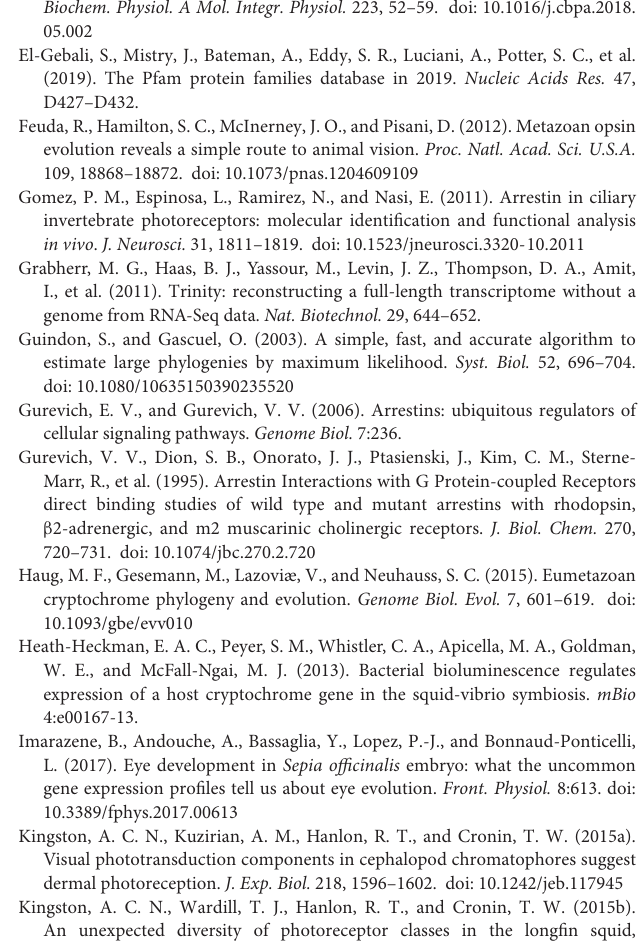
FIGURE S1 | Table of all the sequences used for phylogenetic analyses. FIGURE S2 | Full alignment used for phylogenetic analyses: opsins tree (1), cryptochromes tree (2) and arrestins tree (3). FIGURE S3 | Prediction of transmembrane helices in opsin proteins: Sof_r-opsin1 (1), Sof_r-opsin2 (2), Sof_reti1 (3), Sof_reti2 (4), Sof_xeno1 (5) and Sof_xeno2 (6). FIGURE S4 | Alignment of photosensitive molecules with emphasis on important features. 1. opsins: Alignment of the six opsins from Sepia officinalis. The seven transmembrane domains are indicated in gray boxes (based on S. officinalis rhodopsin annotation-Uniprot O16005). Important features of GPCR from the rhodopsin family are highlighted (black boxes): the two cysteines forming a dissulfide brigde for protein stability (1 and 3), the conserved lysine (4) of the predictive chromophore binding site (K296 in bovine rhodopsin and K305 in S. officinalis rhodopsin/r-opsin1) and the D/ERY domain (2) and NPXXY motif (5) for interaction with G-protein. 2. Cryptochromes: Alignment of cryptochrome sequences from S. officinalis annotated with the two conserved domains: the photolyase domain (dark gray) and the FAD-binding domain (light